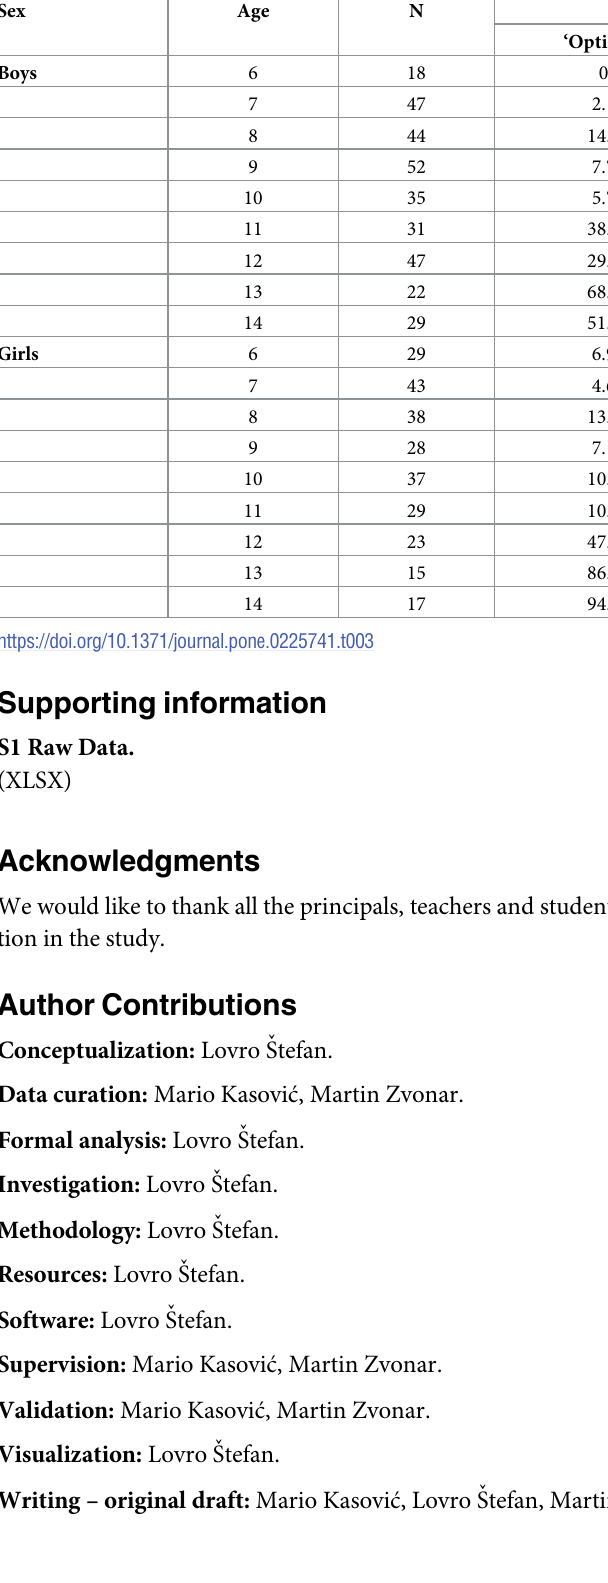
Table 3. Percentage of children carrying ‘optimal’ ( � 10% of body weight) vs. ‘overload’ ( > 10% of body weight) amount of schoolbag weight, Czech Republic. Sex Age